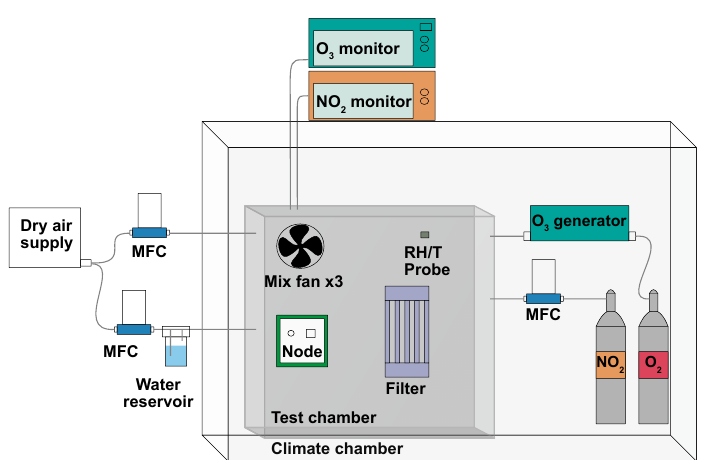
Figure 4. Laboratory calibration setup schematic for the Gen 2 MOx nodes.